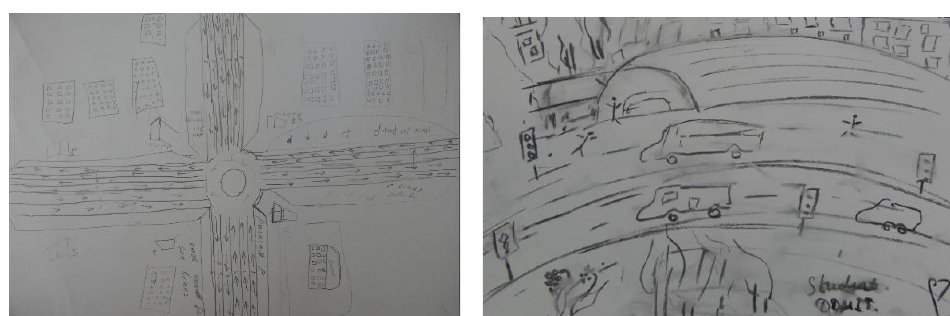
Figure 8. ( a ) A 2021 workshop participant draws the oppressive scale of road infrastructure within Figure 8. ( left ) A 2021 workshop participant draws the oppressive scale of road a residential district of Dushanbe; ( b ) a 2022 workshop participant communicates the road move- ment of traffic and the scale of infrastructure as an overwhelming impediment to pedestrian move- ment between student residential areas and the Tajik National University campus in the north-cen- tral area of the city center.